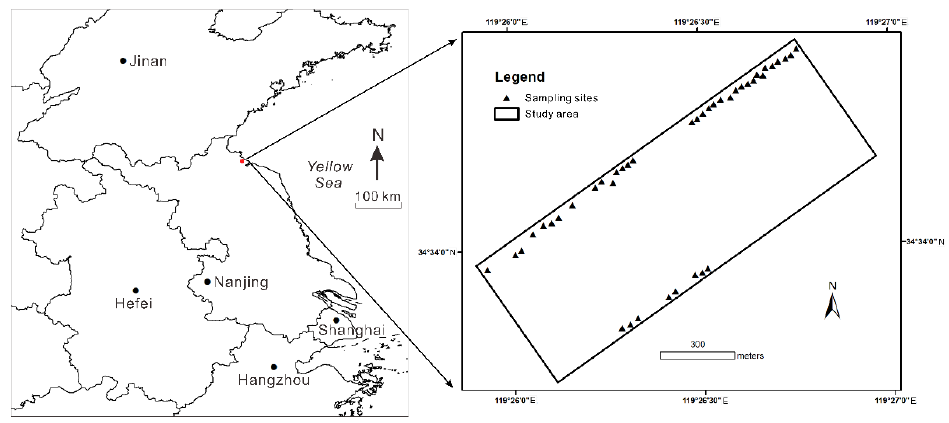
Figure 1. Map shows the location of the study area and the spatial distribution of 42 sampling sites within the